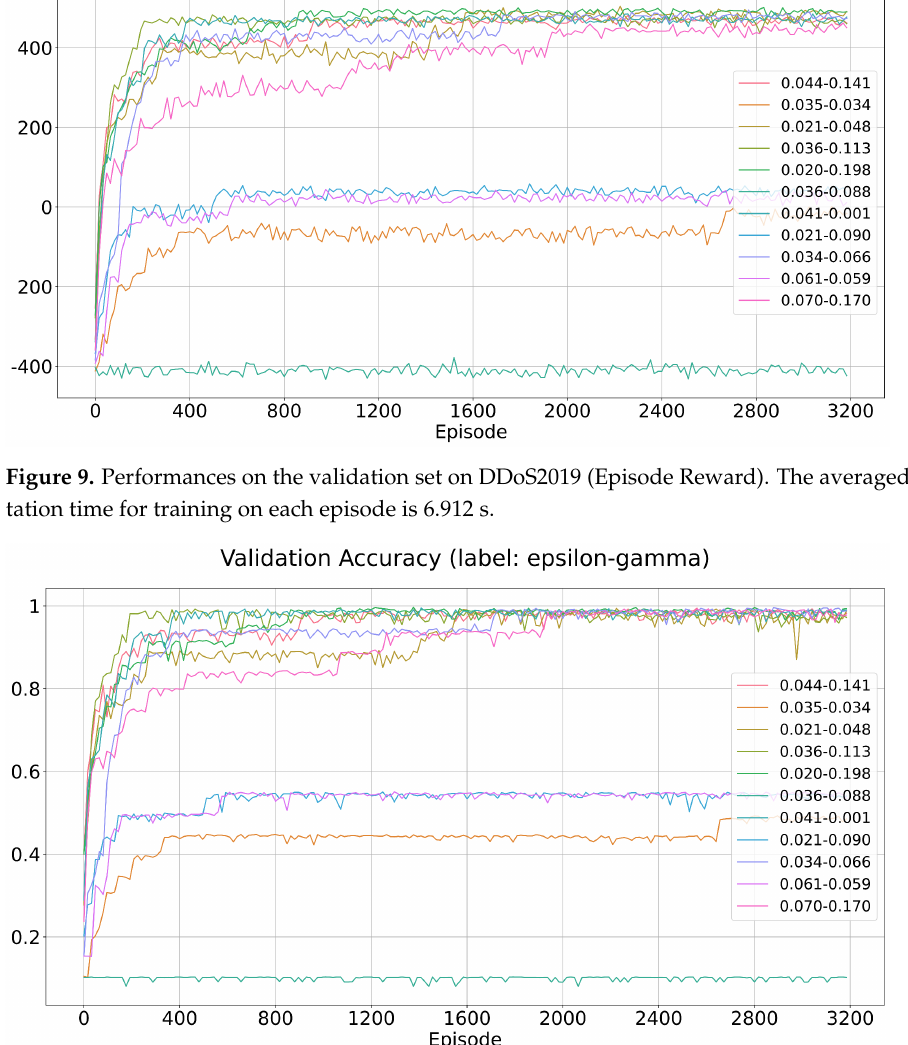
Figure 10. Performanceson the validation set on DDoS2019 (Validation Accuracy).